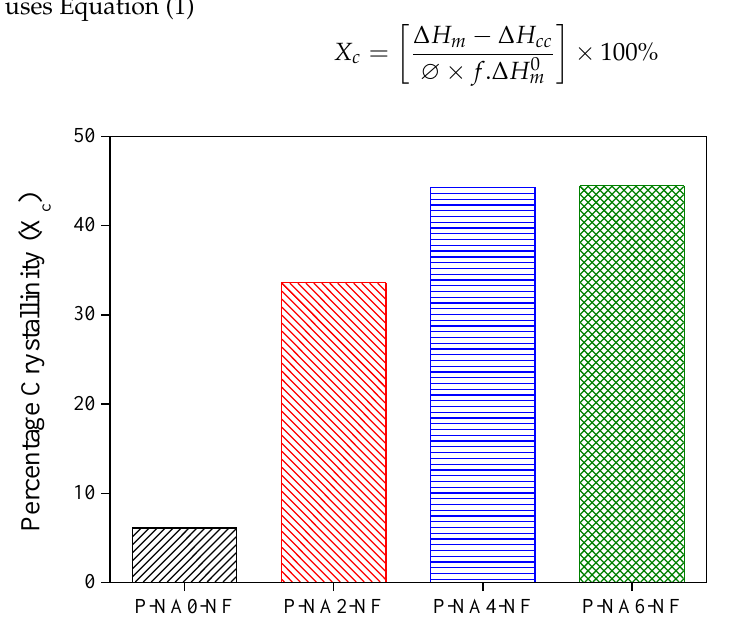
Figure 2. Percentage crystallinity of the NF-reinforced PLA composites with different NA contents. Here, ∆ H m represents the melting enthalpy; ∆ H cc is the cold crystallization enthalpy; f . ∆ H 0 is the 100% crystalline PLA’s melting enthalpy (93.7 J/g). ∅ is the weight fraction of m PLA in the composites Table 2. Thermal characterization of the NF-reinforced PLA composites with different NA con- tents.